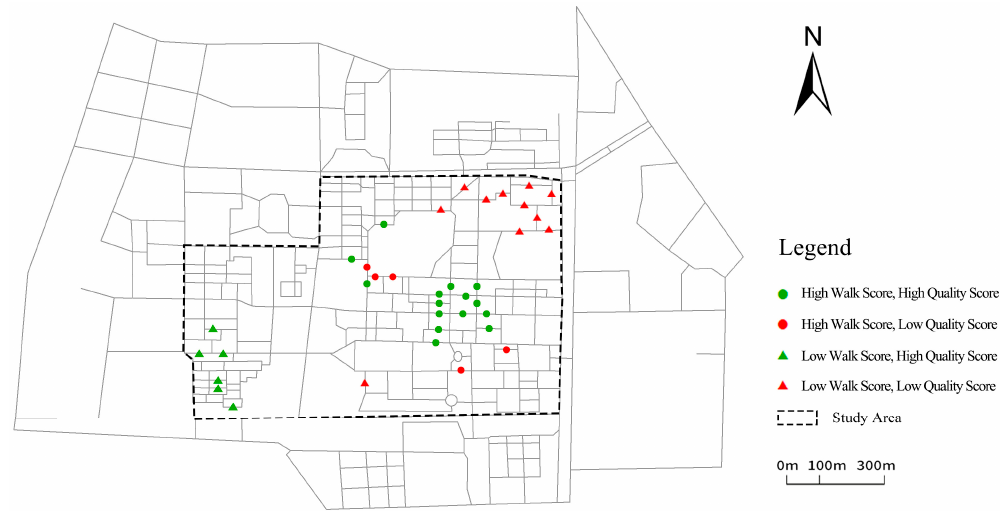
Figure 5. The map of the association between Walk Score and Overall quality score.